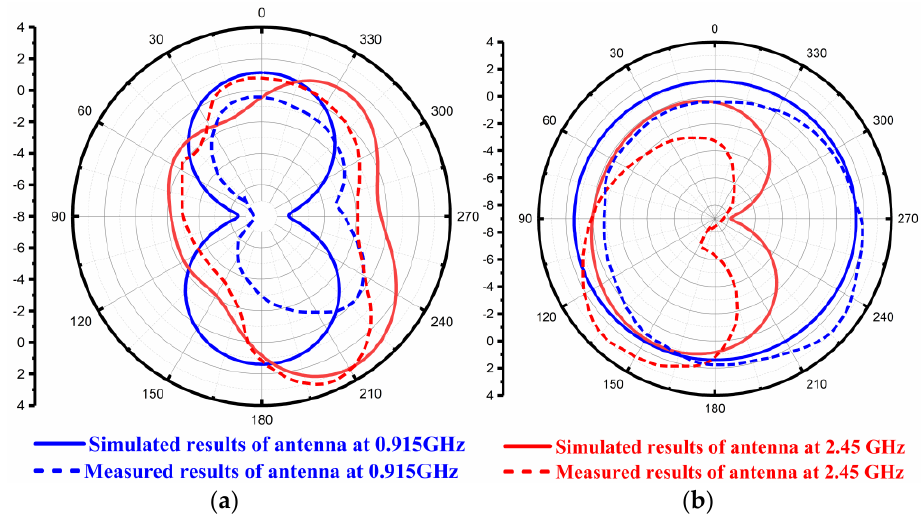
Figure 15. Simulated and Measured Radiation Pattern of the Antenna without AMC Backing. ( a ) Along E-Plane ( b ) Along H-Plane